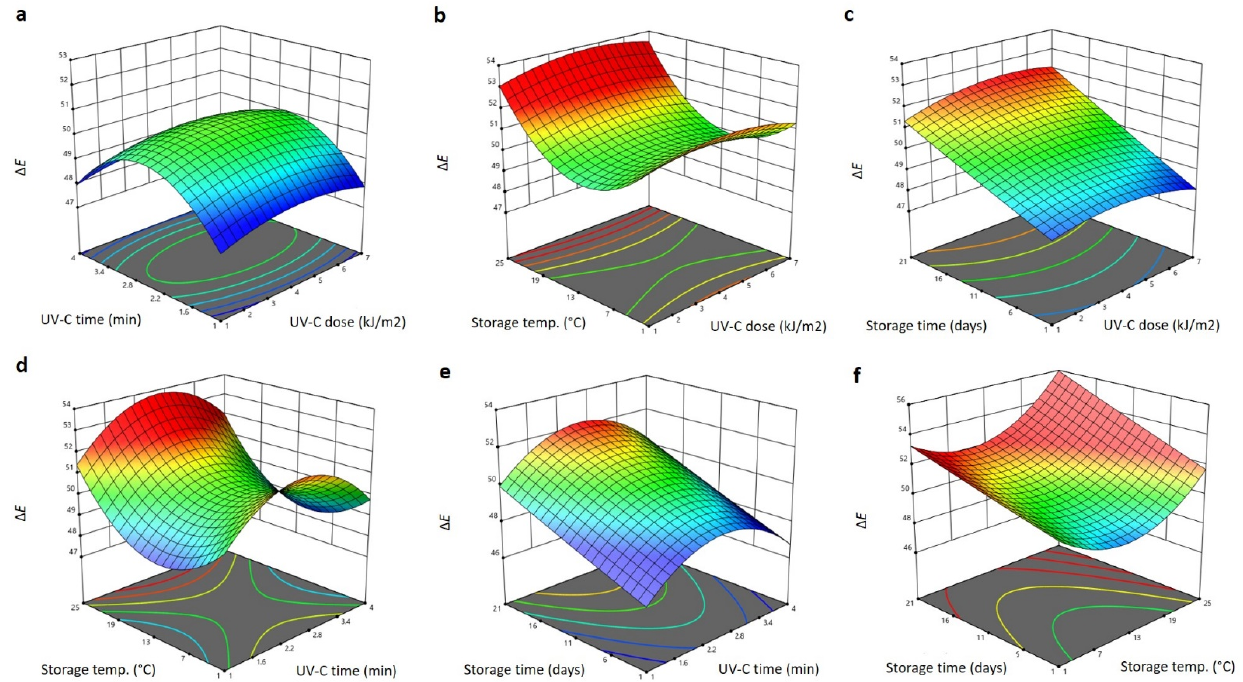
Figure 4. Response surface plots of total color changes (Δ E ) of Barhi dates as a function of UV-C time and UV-C dose ( a ), storage temperature and UV-C dose ( b ), storage time and UV-C dose ( c ), storage temperature and UV-C time ( d ), storage time and UV-C time ( e ), and storage time and storage temperature ( f ).